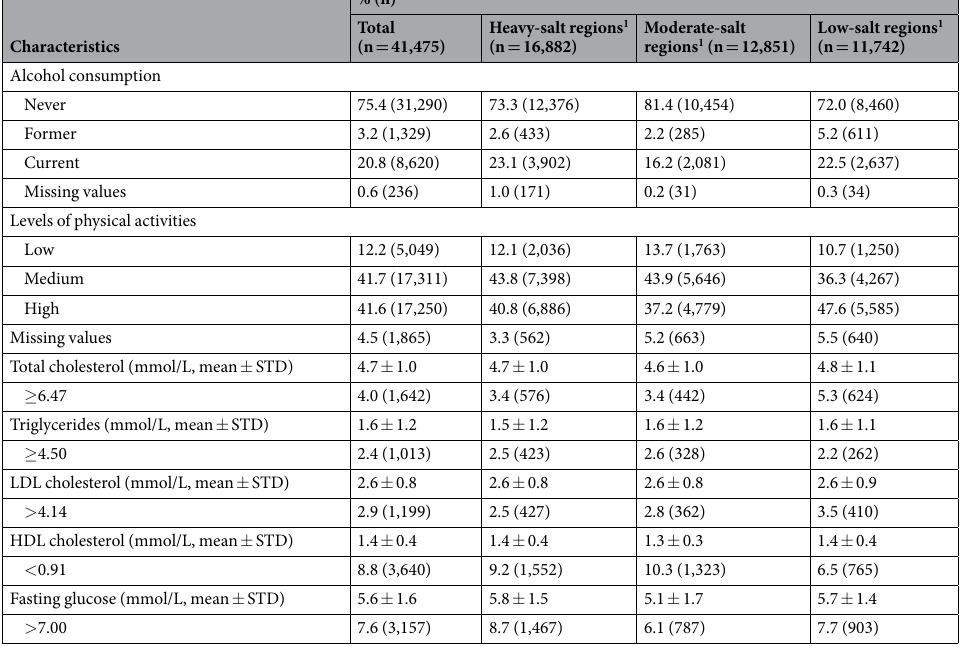
the association of the gram-to-gram ratio for urinary sodium-to-potassium with blood pressure adjusting for the above-mentioned covariates. Systolic/diastolic blood pressure (SBP/DBP) ≥ 140/90 mmHg or self-reported hypertension history or having blood pressure medication was defined as prevalent hypertension. Multivariate logistic regressions were conducted to analyze the associations of hypertension risk with urinary sodium, potas- sium, and ratio of sodium to potassium. The effect of sodium or potassium or their ratio on blood pressure or hypertension risk was further assessed at different levels of sodium ( < 5, 5–6, > 6 g/day) or potassium ( < 1.8, 1.8–2.2, > 2.2 g/day), or sodium-to-potassium ratio ( < 2.3, 2.3–3.0, > 3.0). Three regions were divided by daily salt intake according to National Dietary Survey in 2002, which was conducted using multi-stage random cluster sampling method and 272,023 population were screened across 31 administrative regions 23 . For example, more than 8 grams of daily salt intake was defined as